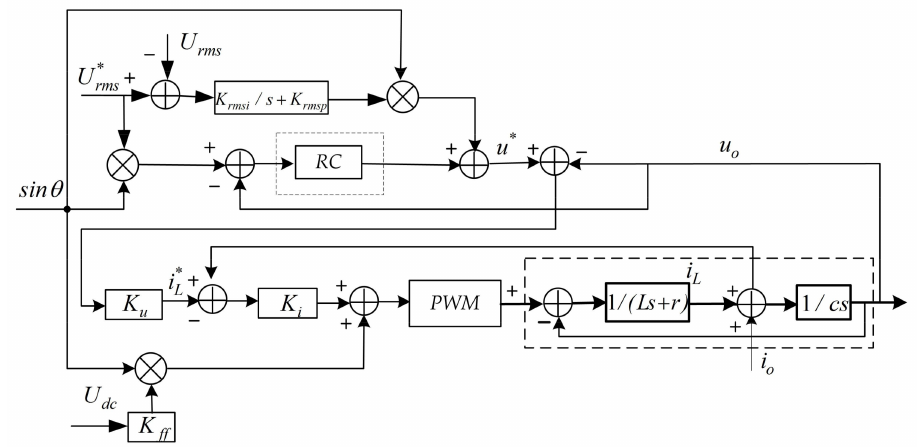
Figure 5. Voltage control block of the